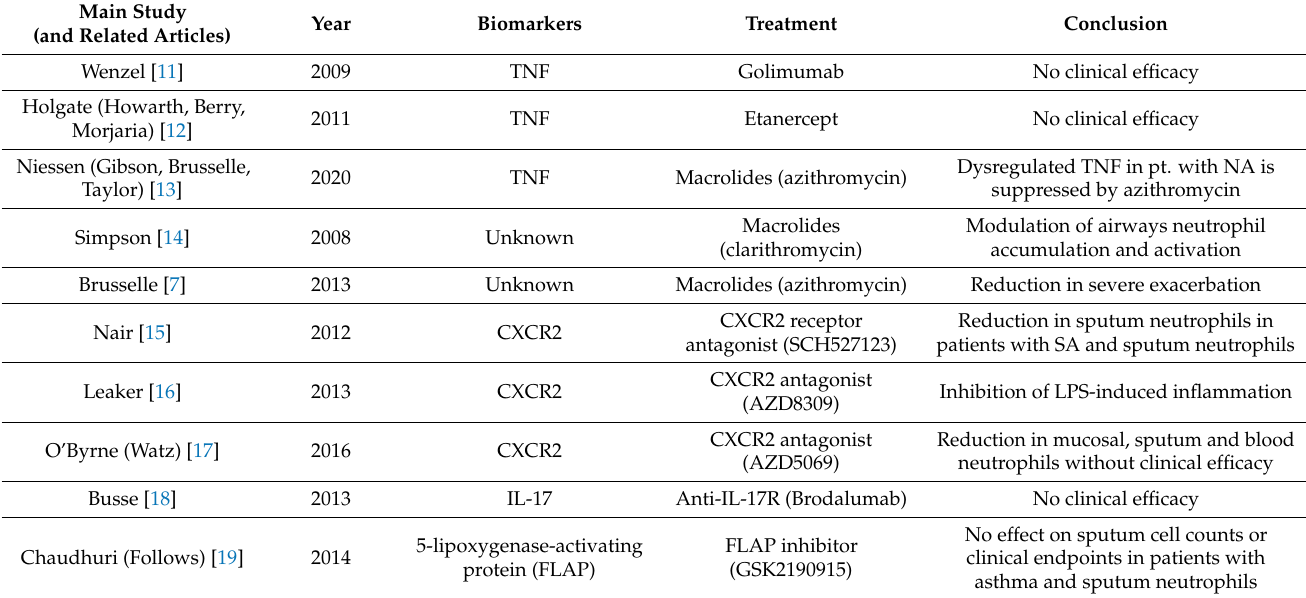
Table 1. Targeted treatment for neutrophilic asthma.